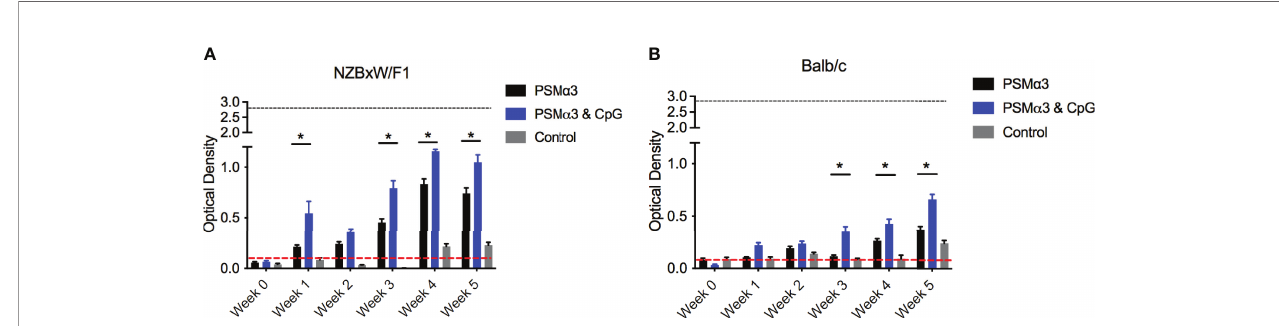
FIGURE 3 | Intraperitoneal injection of synthetic PSM ⍺ 3 fi brillized with CpG DNA elicits an autoantibody response. (A) NZBxW/F1 or (B) Balb/c mice were injected bi-weekly with PSM a 3 fi brillzed alone (black bar) or fi brillzed in the presence of CpG DNA (blue bar) or control mice were injected with sterile PBS (gray bar). Mice were tail bled weekly and the production of anti-dsDNA autoantibodies were detected (Optical density 650-405nm). Black dotted line represents the maximum anti- dsDNA autoantibody production of positive control sera and the red dotted line represent autoantibody detection in naïve serum. Mean and SEM graphed; signi fi cance was calculated using a 2-way ANOVA and Tukey ’ s multiple comparisons tests (*, P < 0.05).